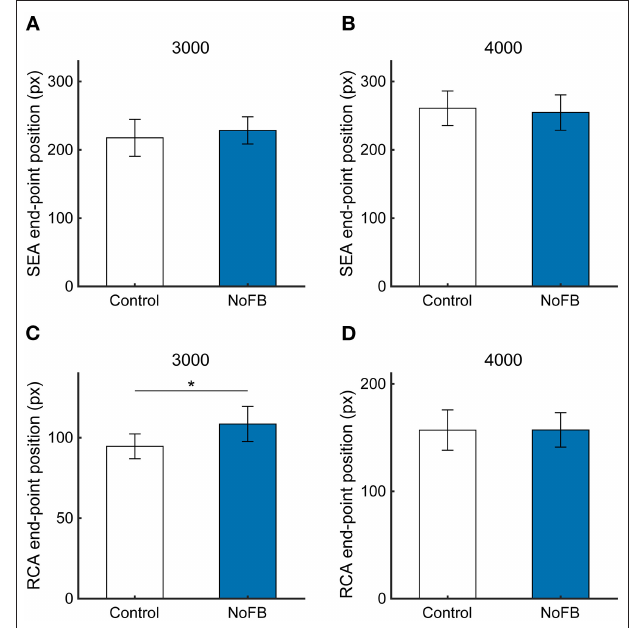
FIGURE 7 | (A,B) Onset time and (C,D) offset time at target speeds of 3,000 and 4,000 pixels/s. Orange and gray bars show SEA and RCA, respectively. Error bars are SEM. ** p < 0.01.